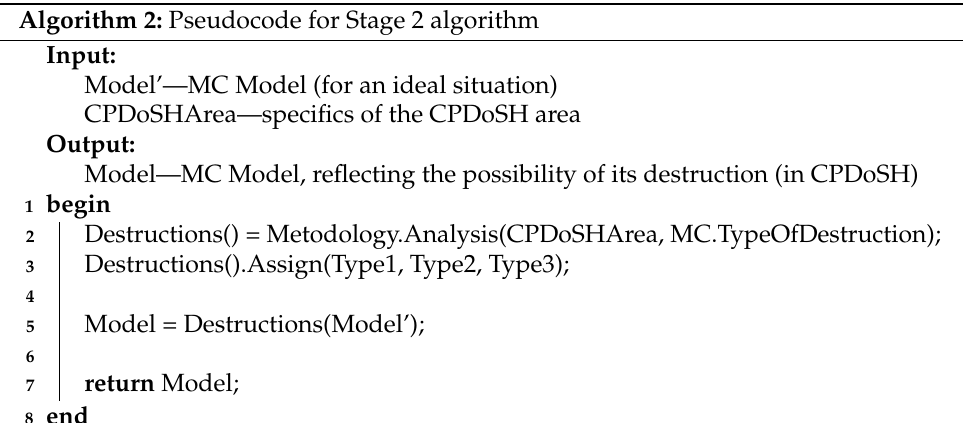
Algorithm 2: Pseudocode for Stage 2 algorithm